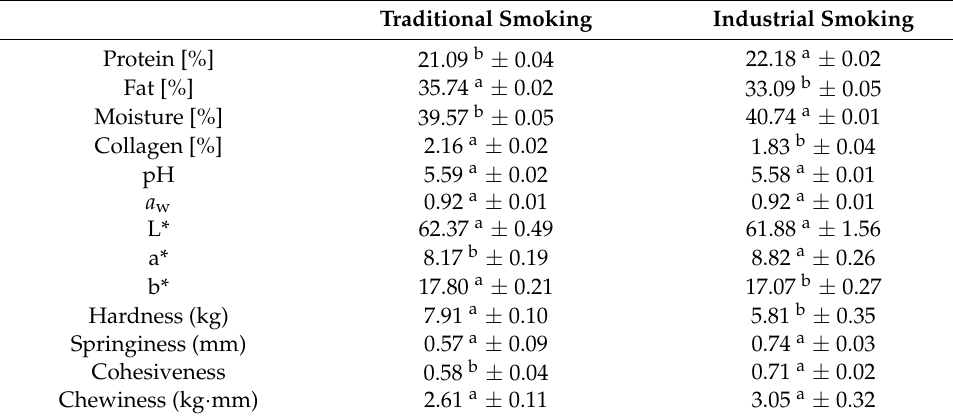
Table 1. Physico-chemical properties of Slavonska slanina . Traditional Smoking Industrial